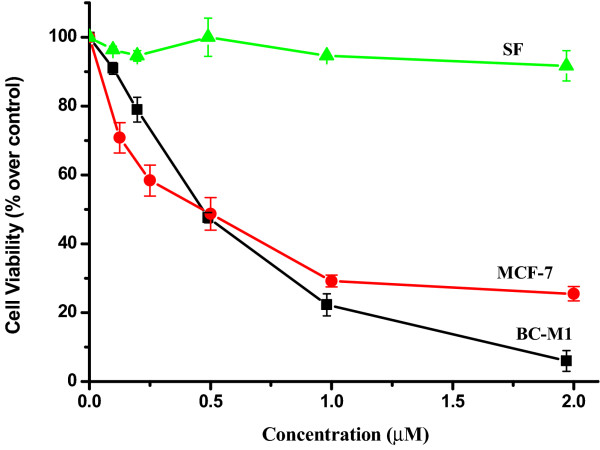
Bis-aziridinylnapthoquinone (AZ-1) inhibited the proliferation of three cell lines, skin fibroblasts (SF), BC-M1 and MCF-7. Cells were seeded for 18 hours before the addition of AZ-1 with various concentrations. The death effects of these three cell lines induced by various concentrations of AZ-1 were compared by the MTT assay. The MTT assay was used to determine the cell viability after an additional 24 hours of culture. Data are from quadruplet wells and are representative of three separate experiments.